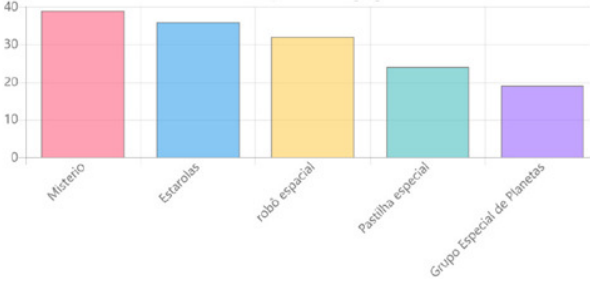
Figure 14. Results of the scores of the five groups who played the